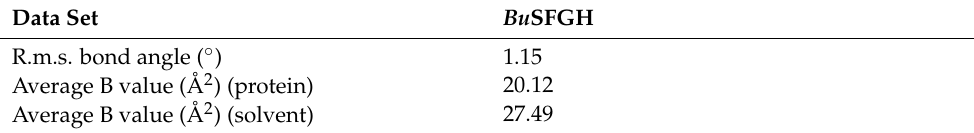
Table 1. Cont. Data Set Bu